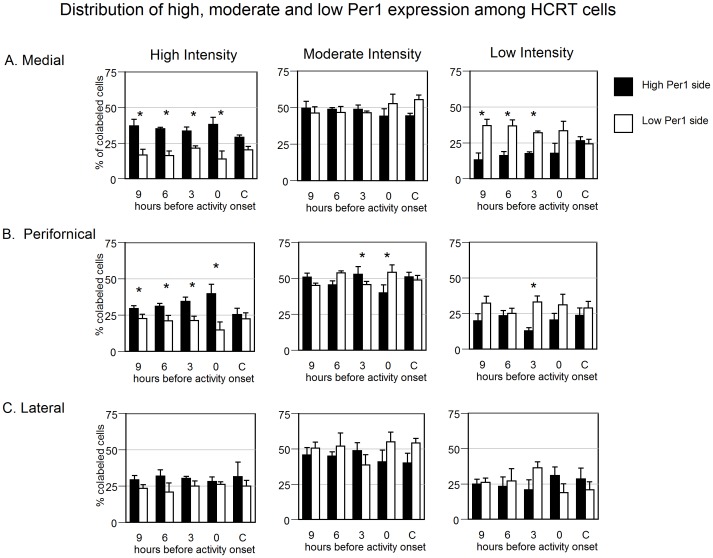

Per1 intensity quantified by category of intensity within HCRT cells.Distribution of cells expressing high (left), moderate (center) or low (right) levels of Per1 in the (A) medial, (B) perifornical and (C) lateral regions of the HCRT-expressing cells of the LH/DMH. * p<0.05 vs. low side.